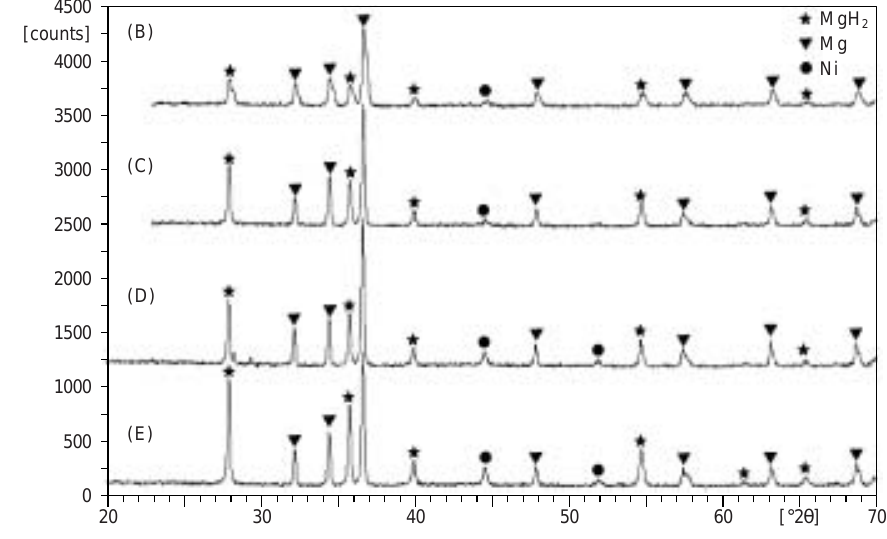
Fig. 6 XRD patterns for (B) MgH 2 -1 at % Ni - 30 min, (C) MgH 2 -1 at % Ni - 90 min, (D) MgH 2 -2 at % Ni - 30 min and (E) MgH 2 -2 at % Ni - 90 min. Stoichiometric amounts of Mg-x at % Ni and hydrogen were used for the absorption